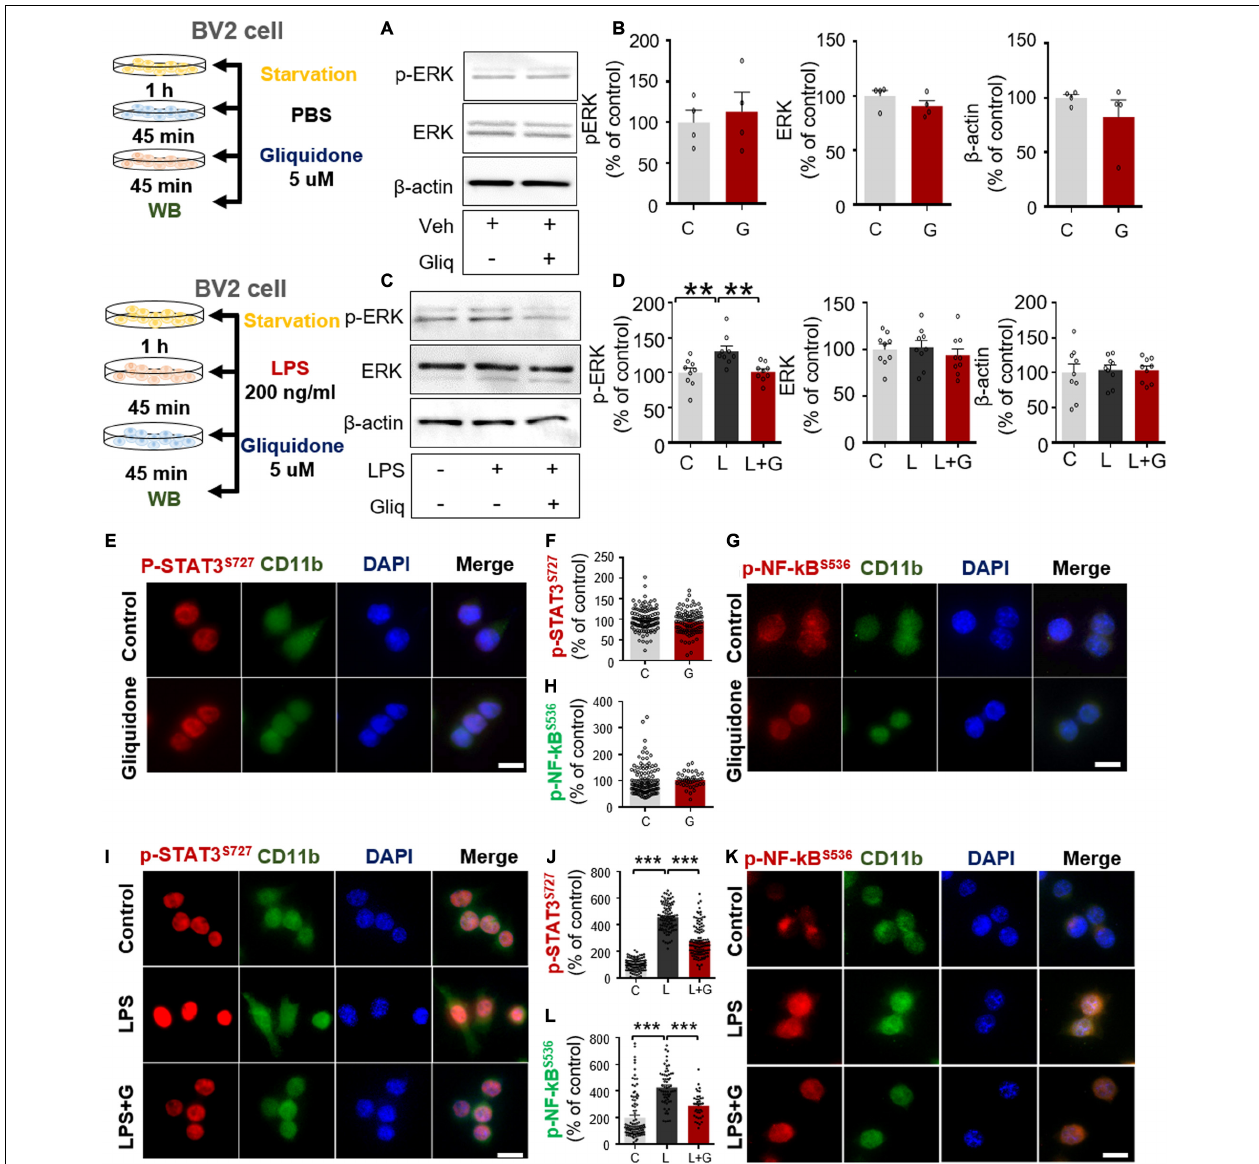
FIGURE 7 | Gliquidone suppresses LPS-mediated ERK and STAT3/NF- κ B phosphorylation in BV2 microglial cells. (A,B) Western blot analysis of p-ERK, ERK, and β -actin levels in cells treated with gliquidone alone or vehicle as shown ( n = 4/group). (C,D) Western blot analysis of p-ERK, ERK, and β -actin levels in cells treated sequentially with LPS and gliquidone as indicated ( n = 9/group). (E–H) Immunocytochemistry analysis of CD11b and p-STAT3 S 727 levels or CD11b and NF- κ B S 536 levels in cells treated with gliquidone or vehicle (p-STAT3 S 727 : C, n = 112; gliquidone, n = 98; p-NK-kB S 536 : C, n = 149; gliquidone, n = 70). (I–L) Immunocytochemistry analysis of CD11b and p-STAT3 S 727 levels or CD11b and NF- κ B S 536 levels in cells treated sequentially with LPS and gliquidone (p-STAT3 S 727 : C, n = 119; L, n = 100; LPS + gliquidone, n = 116; p-NK-kB S 536 : C, n = 101; L, n = 61; LPS + gliquidone, n = 37). ** p < 0.01, *** p < 0.001. Scale bar = 20 µ M.